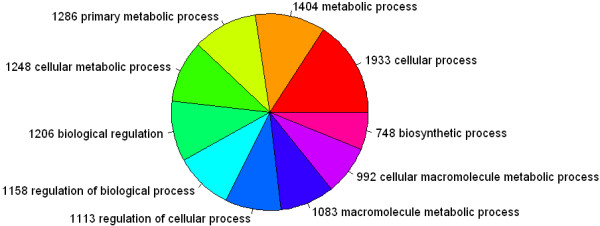
Count proportion pie of the GO analysis of Biological Process. The chart shows the top ten counts of the significant enrichment terms of designated gene involving Biological Process